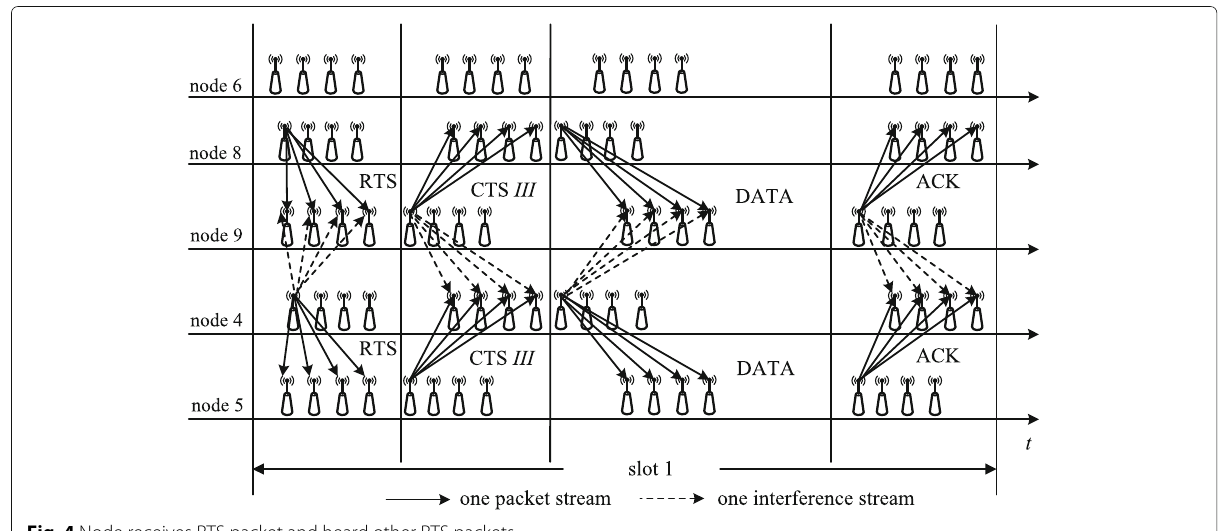
Fig. 4 Node receives RTS packet and heard other RTS